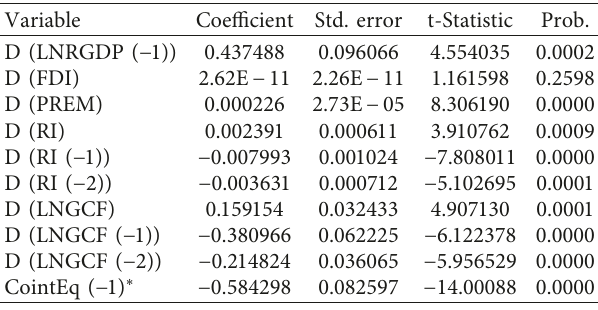
Table 6: Results of short-run ARDL and error correction model. Variable Coefficient Std. error t-Statistic